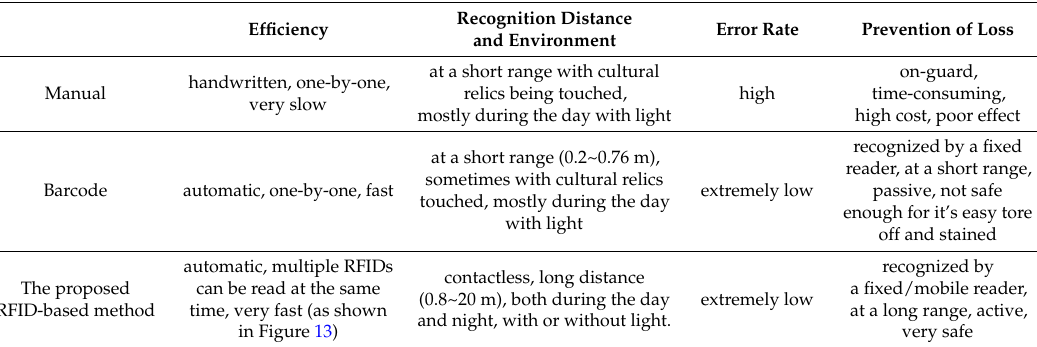
Table 2. Comparison of the proposed RFID-based system with traditional means.